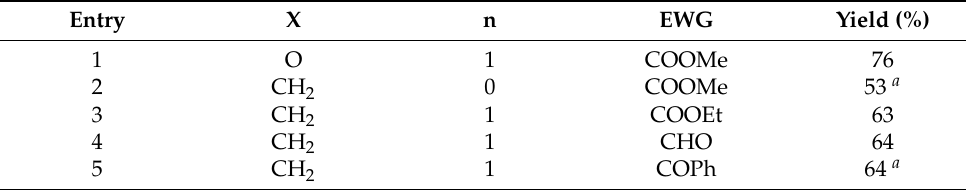
Table 14. Scope of Tang’s catalytic intramolecular cyclopropanation reaction (Scheme 42).